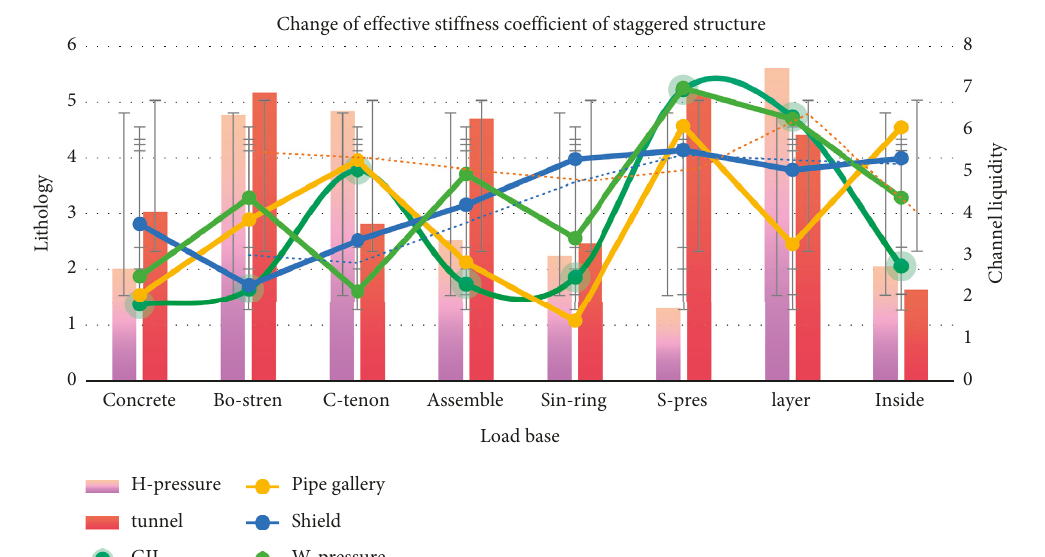
Figure 8: Change of effective stiffness coefficient of staggered